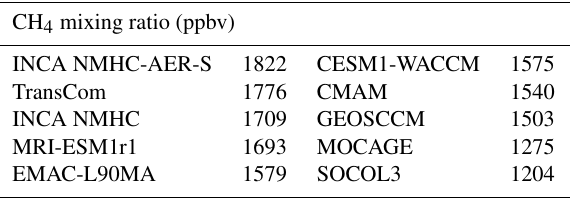
Table 6. Global mean tropospheric CH 4 mixing ratios as simulated by LMDz using different OH fields and repeating year 2000 over 30